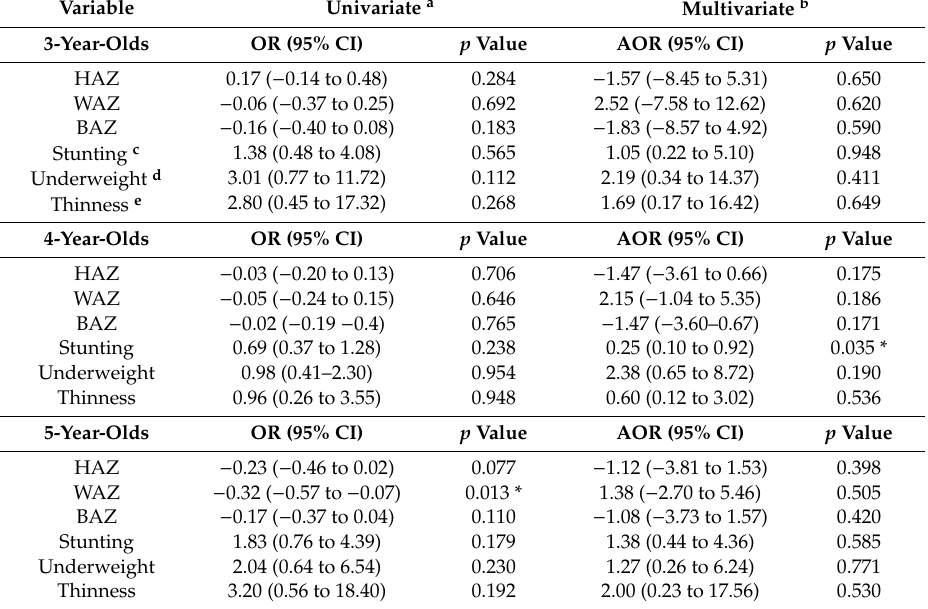
Table 5. Univariate and multivariate association between dietary diversity and nutritional indicators stratified by